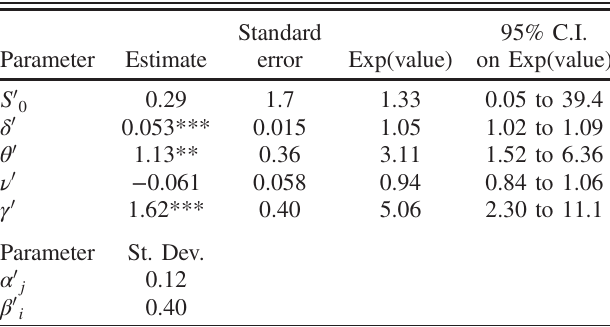
TABLE VI. Values of the best fit parameters in model (2). Bootstrapping was used to determine 95% CIs. * indicates p < 0 . 05 , (cid:4)(cid:4) ¼ p < 0 . 01 , (cid:4)(cid:4)(cid:4) ¼ p < 0 . 001 . Data from 133 students are included in the